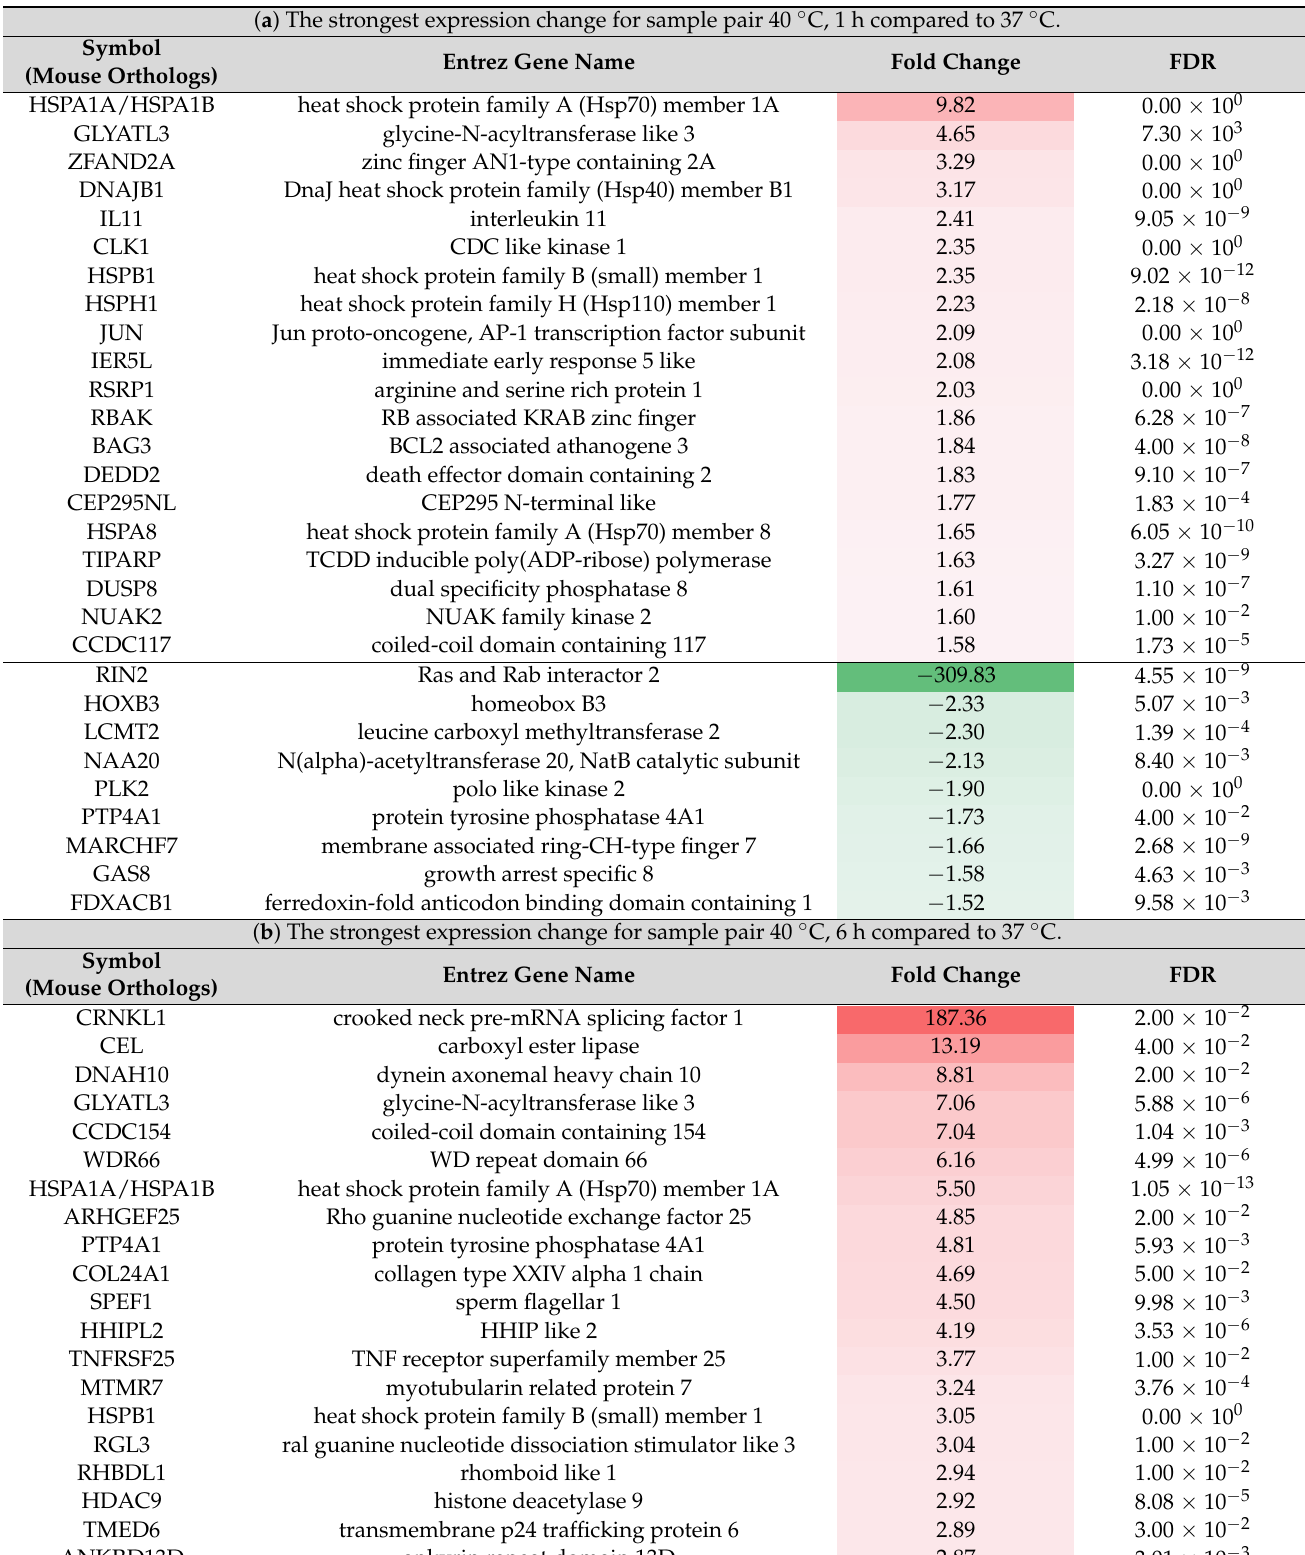
Table 1. The mouse orthologs of the top 20 most increased (red) and decreased (green) genes exhibiting statistically significant expression change (fold change > 1.5, FDR < 0.05) *. The complete dataset with the original Chinese hamster genes is listed in Table